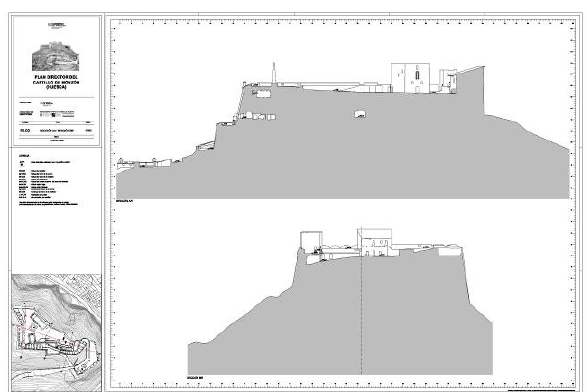
Fig. 8. Scanner-laser survey: Sections of the Castle of Monzón (Huesca,